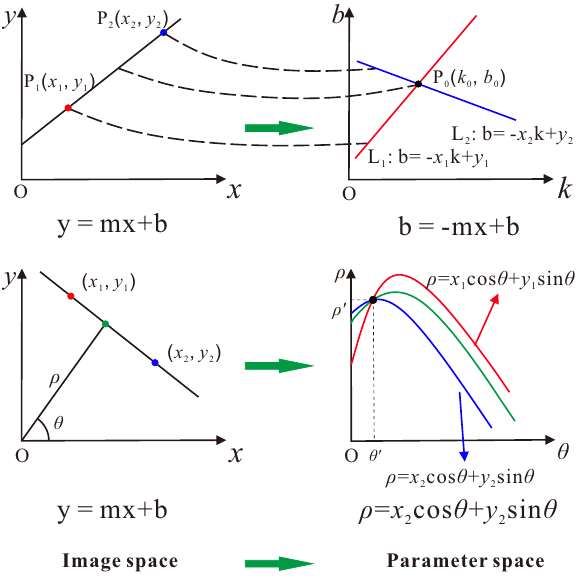
Figure 3. The flow chart of the Hough Transform